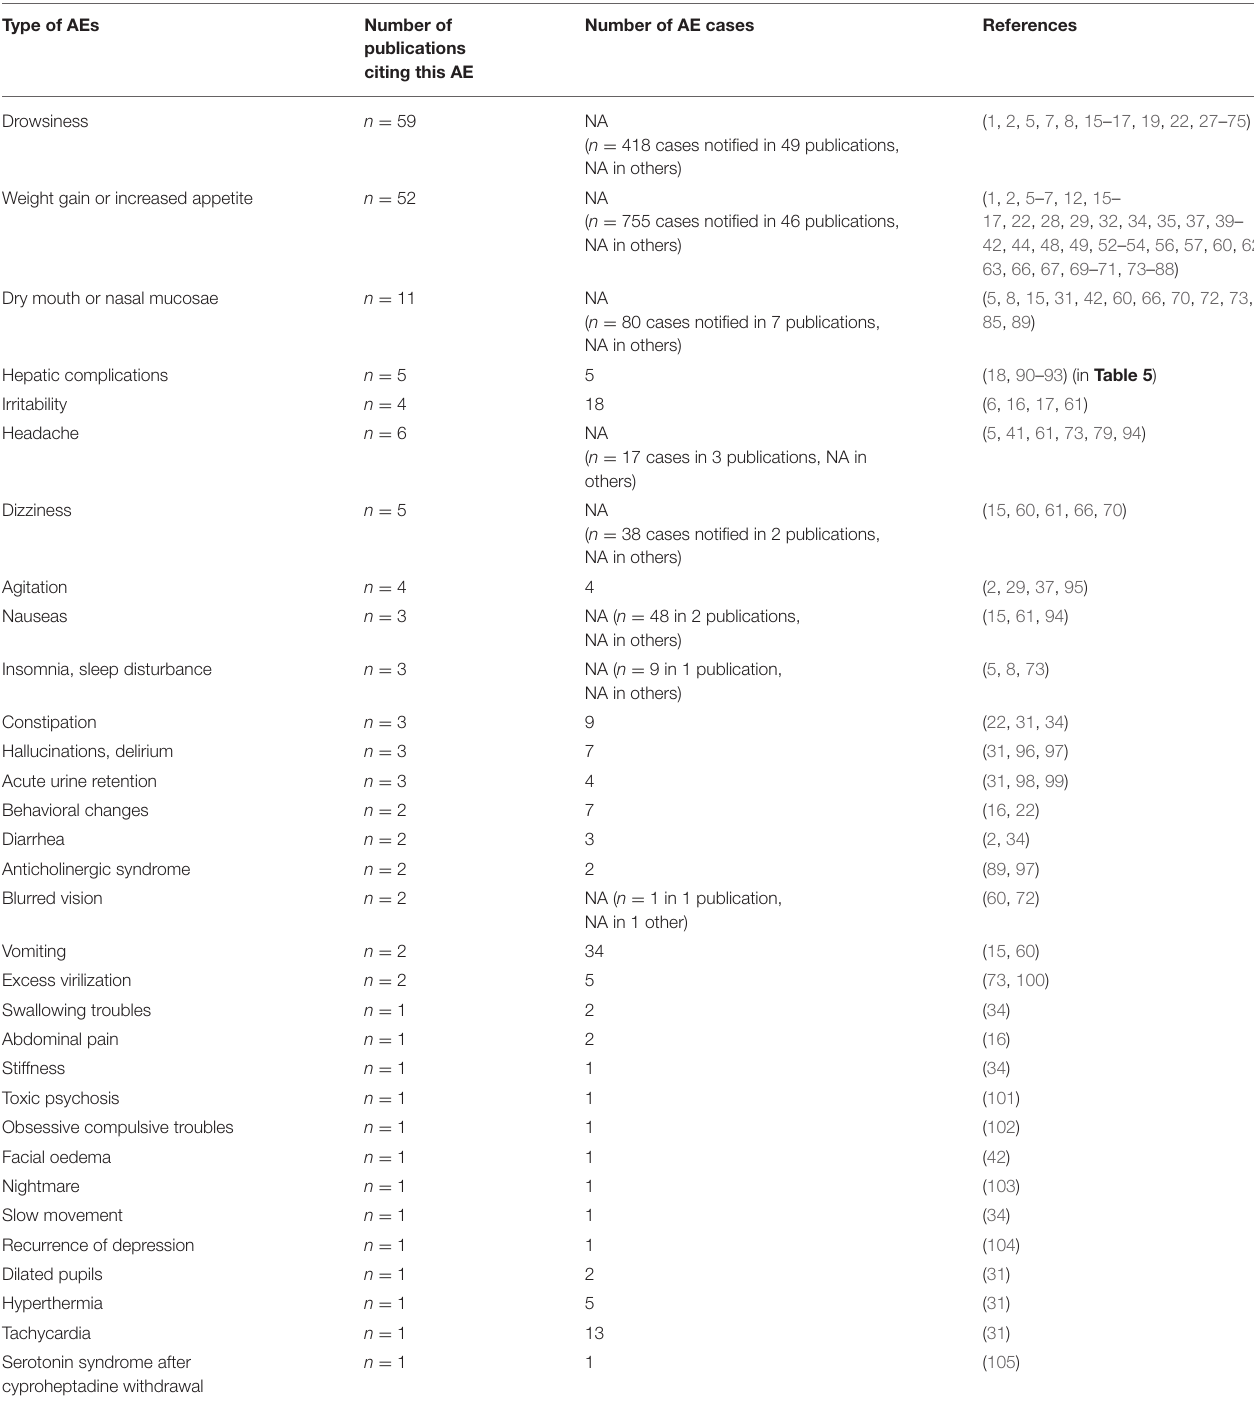
TABLE 4 | Adverse effects (AEs) with cyproheptadine (overdose cases excluded) reported in the